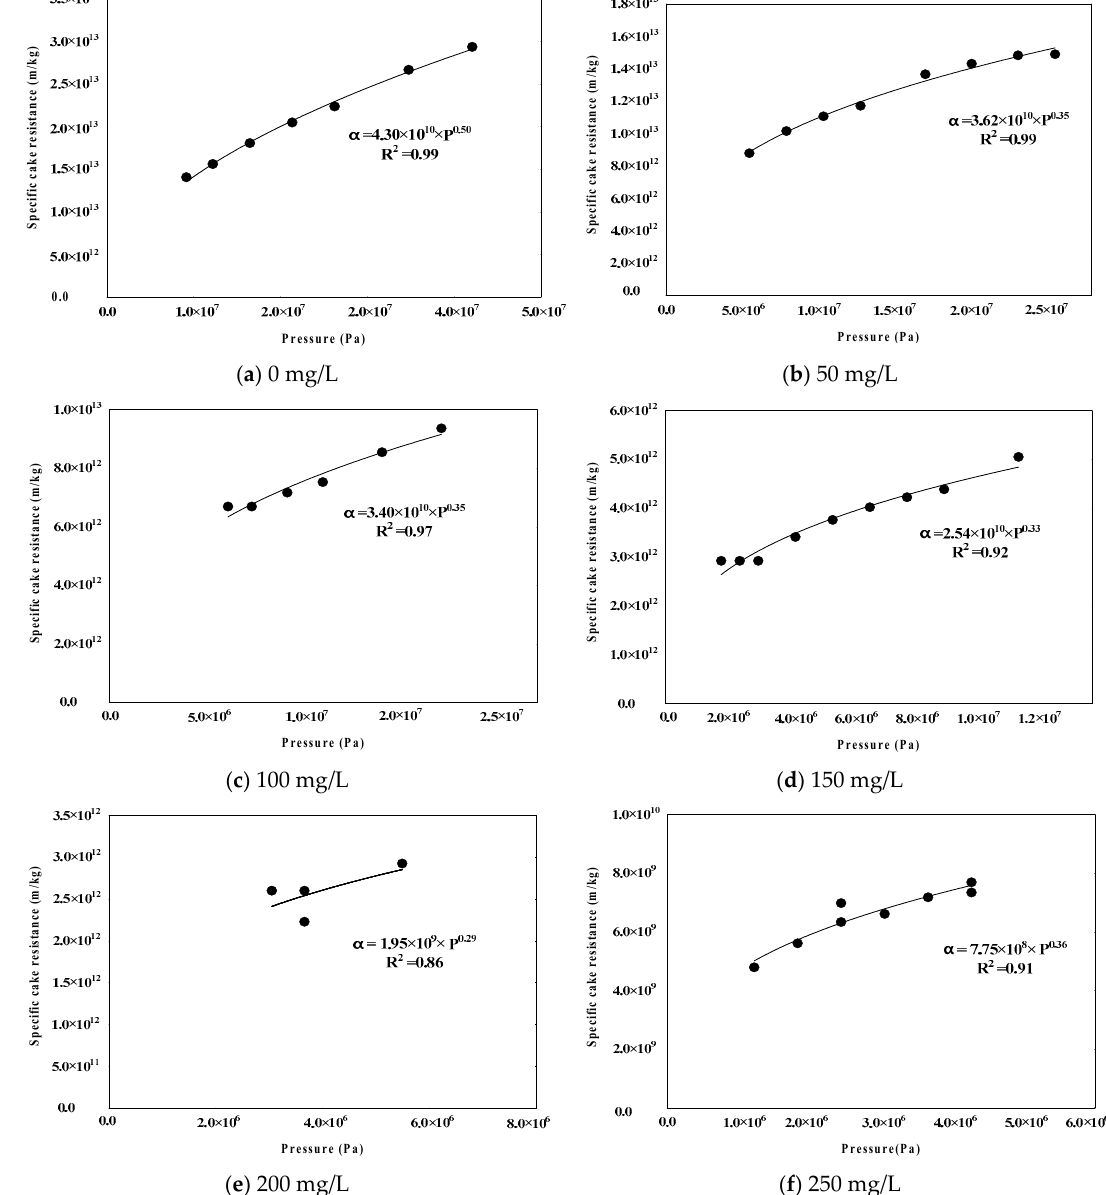
Figure 7. Compressibility index with Polyaluminum chloride (PaCl) dosage.